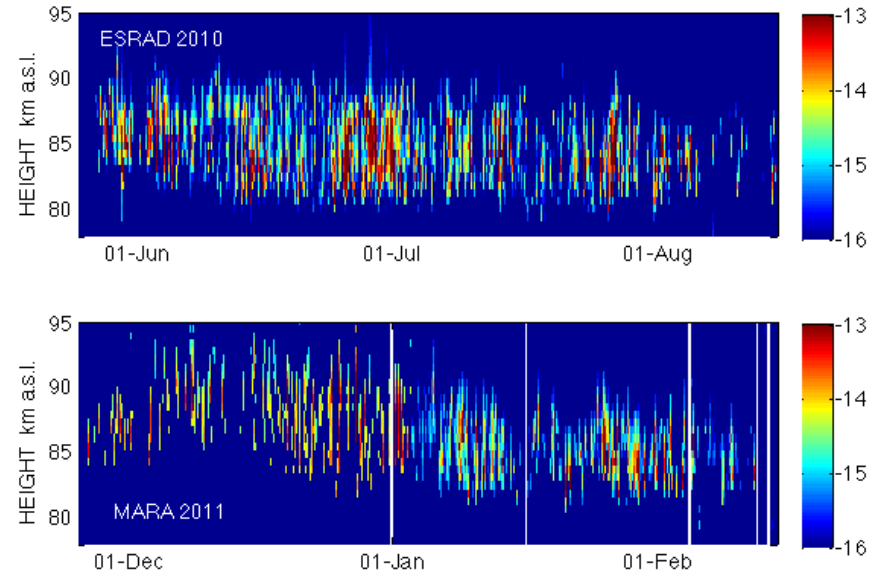
Fig. 2. Examples showing volume reflectivities ( η N ) for two complete seasons of PMSE observations, the upper panel for ESRAD in the Arctic, the lower for MARA in Antarctica. Colour scale is the log 10 of volume reflectivity, η N .